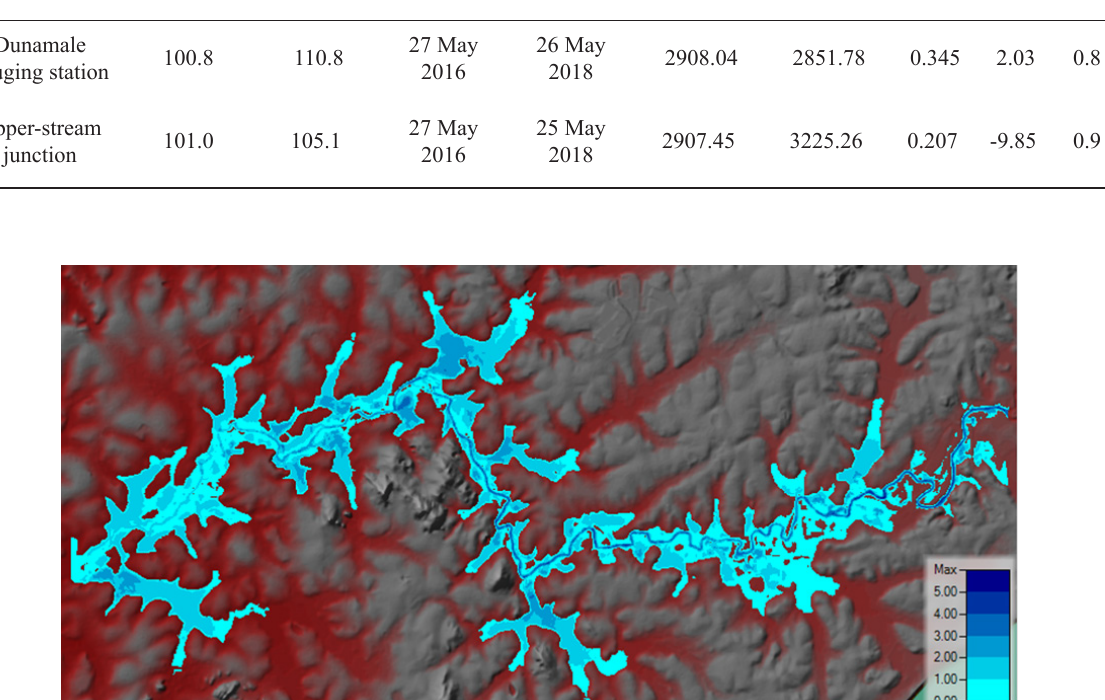
Figure 7: Forecasted flood area for flood event occurred in May